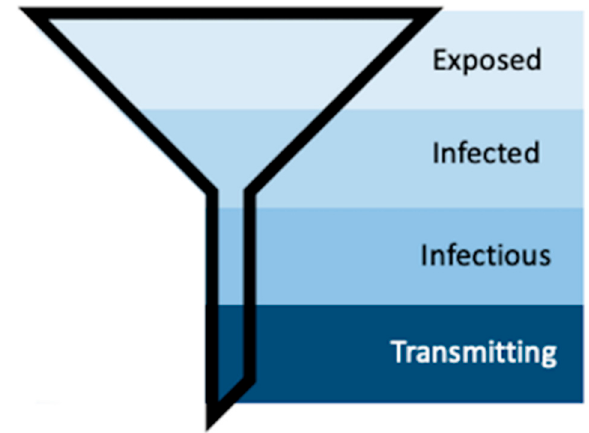
Figure 8. Schematic representing the process of vector competence. As susceptible mosquitoes progress through the stages of vector competence, the population funnels down into the transmitting population, the small group that our method aims to further describe. Supplementary Materials: The following are available online at www.mdpi.com/xxx/s1, Table S1: Limit of detection for novel assay for qRT-PCR and neutral red plaque assay, Table S2: Titers of individual forced saliva at 24 days post-exposure, Table S3: Titers of collected serum and collections from Vero inoculation.